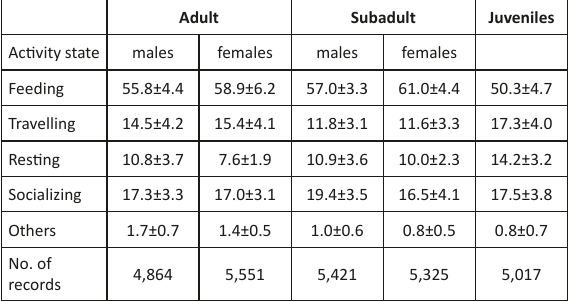
Table 2. The mean (± SD) proportion of time (%) spent on the activity states by the age/sex